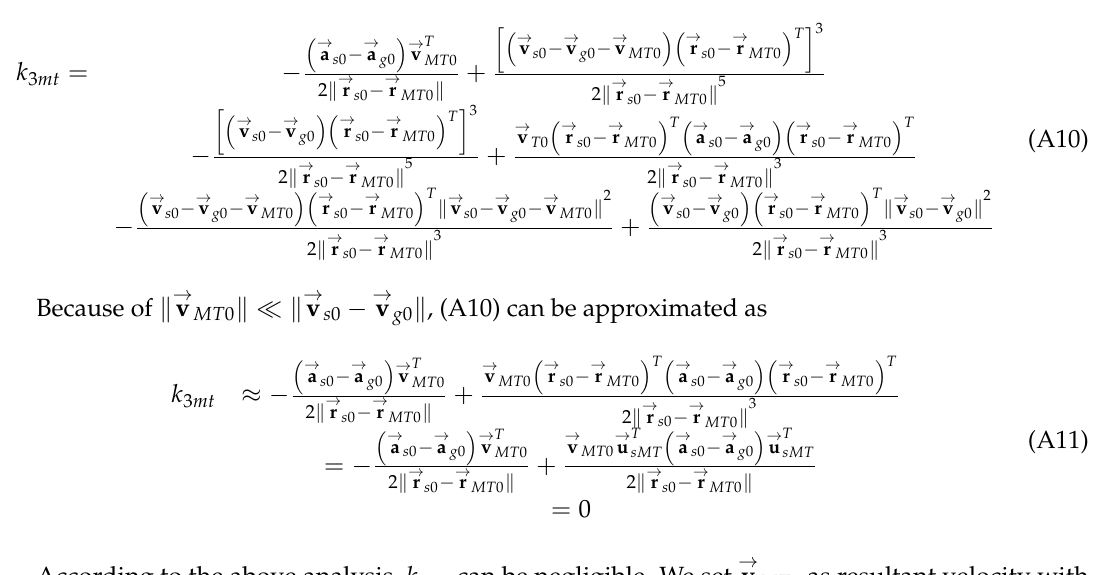
Figure A1. The influence of Target Motion on